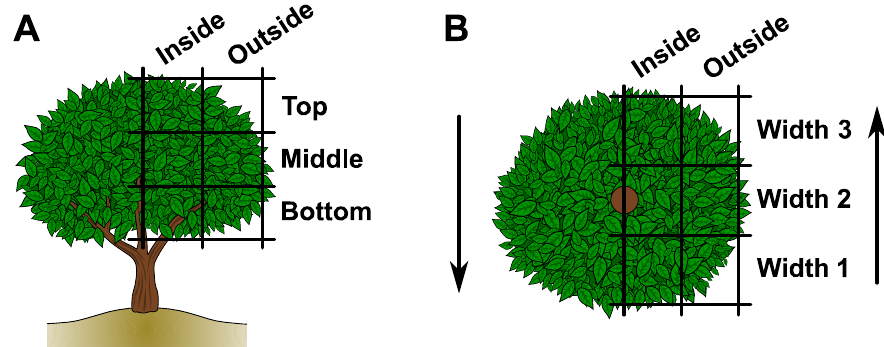
Figure 2. Quadrants of the canopy. ( A ) Side view and ( B ) top view of a standard citrus tree. Arrows indicate the forward sense of the sprayer.